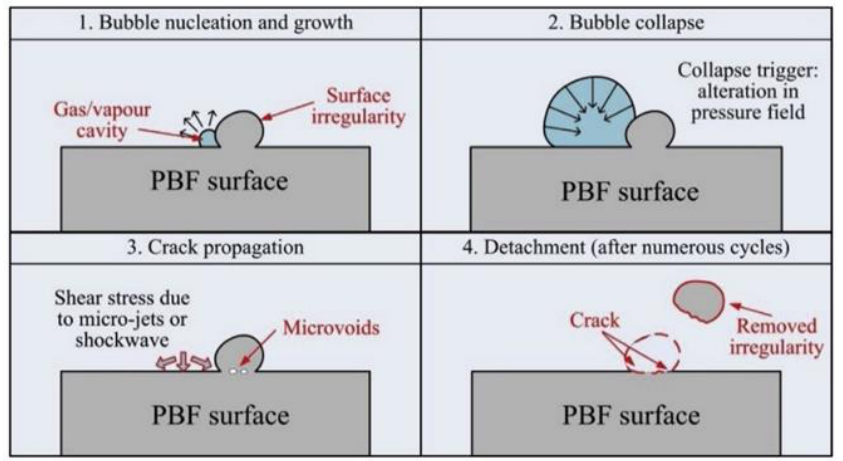
Figure 7. Heterogeneous cavitation on PBF surfaces (reproduced with permission from Ref. [140], Copyright 2020,